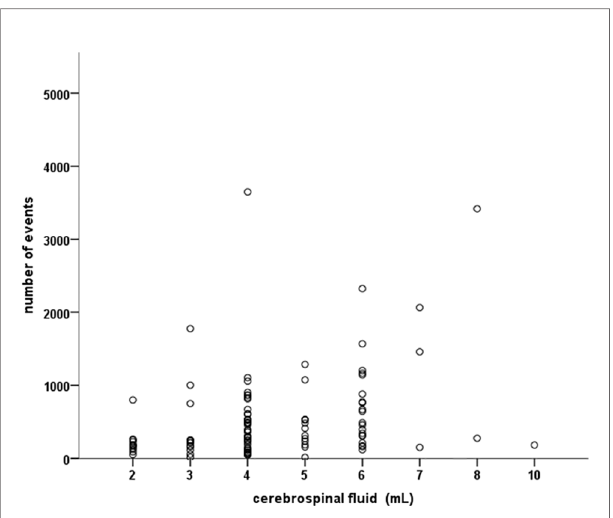
FIGURE 1 | Positive correlation between the ml of cerebrospinal fl uid and the number of cells (events) analyzed by fl ow cytometry (p 0.36; P <